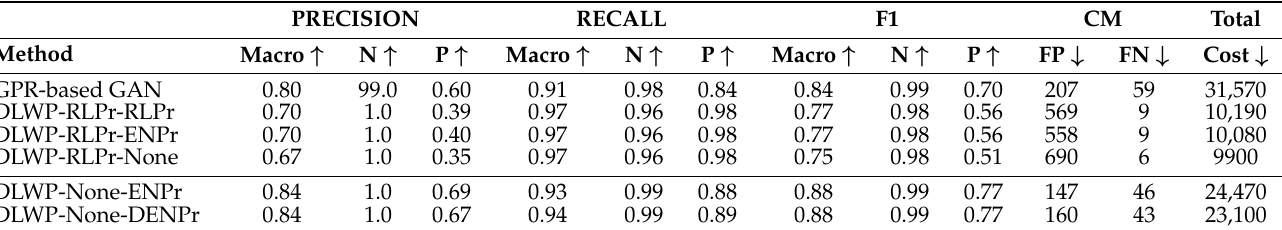
Table 2. Results for fault detection systems. We consider metrics Precision, Recall F1, and False Positives (FP) and False Negatives (FN). The total misclassification cost is featured in the last